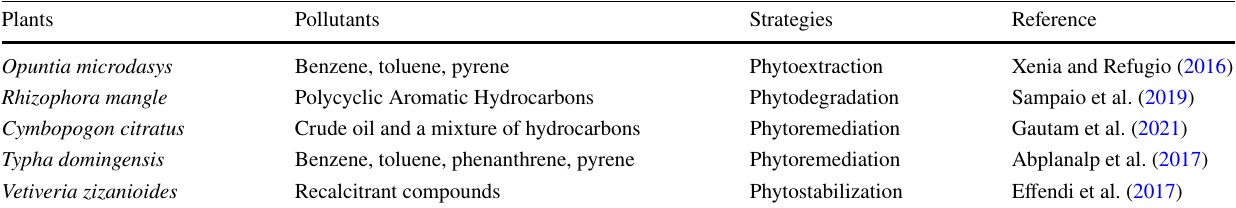
Table 4 Phytoremediation of petroleum contaminant